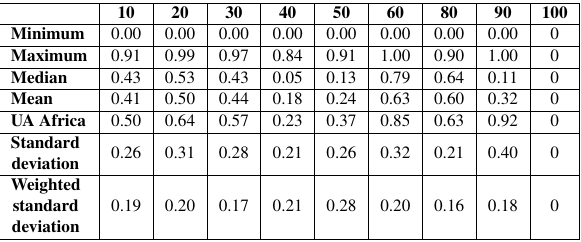
Table 7. Summary statistics for UA (Class labels corresponding